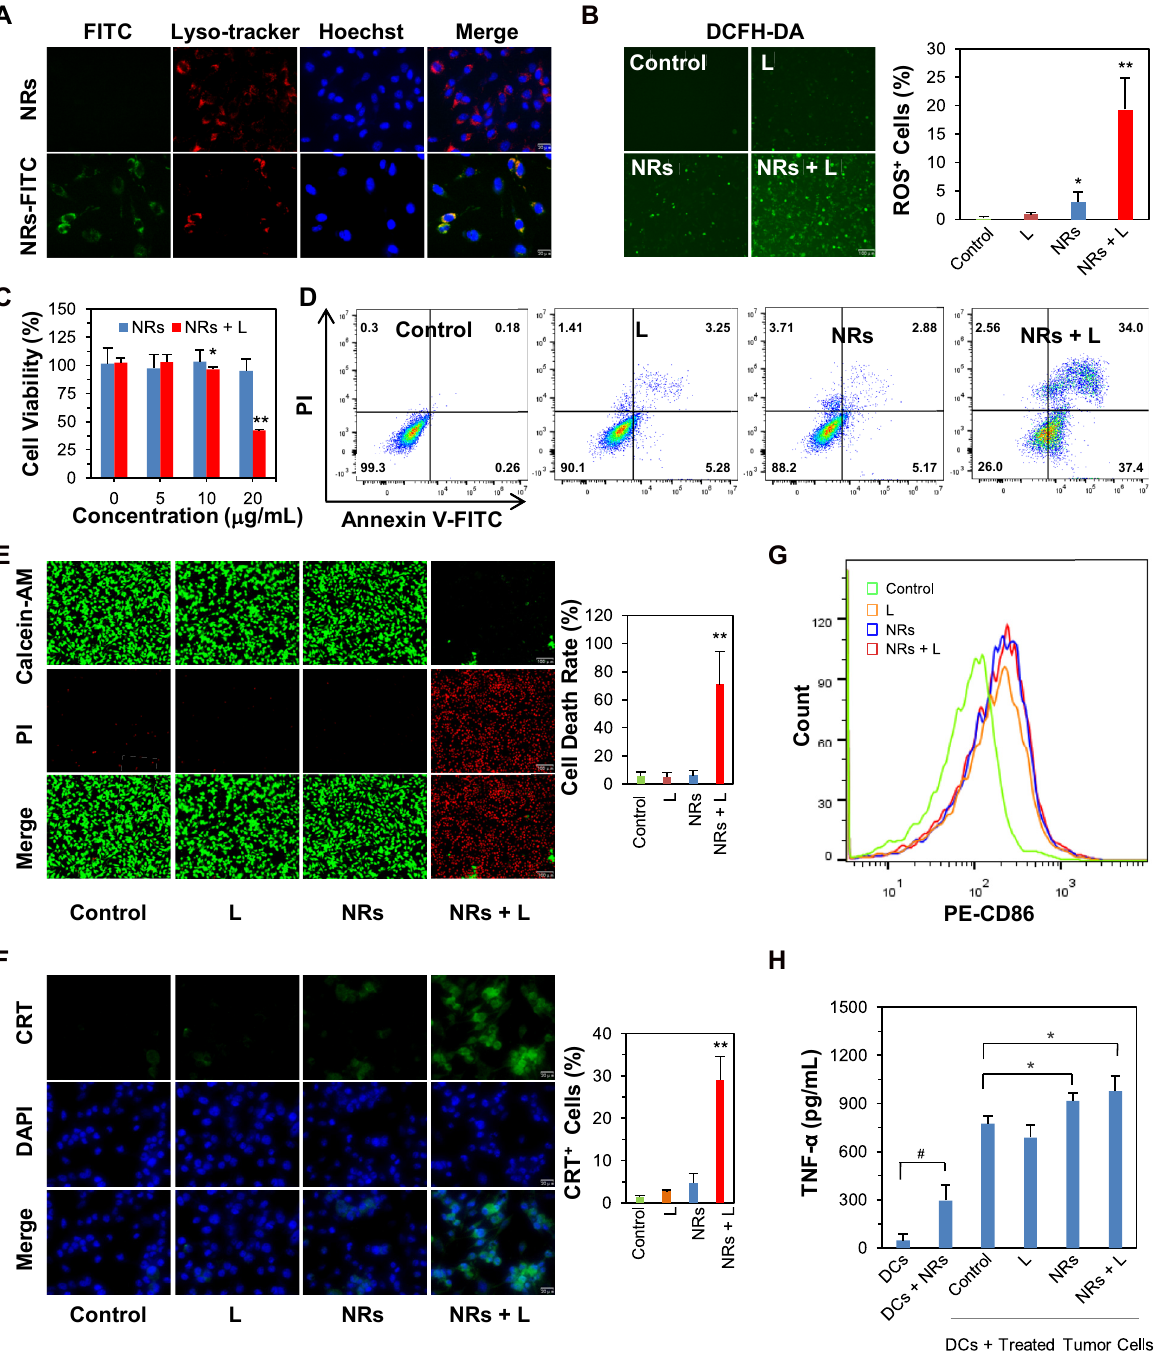
Figure 2: Immunogenic tumor cell death induced by Fe 2 P-PEG-Mal NRs based PTT. (A)FluorescenceimagesofintracellularlocalizationofNRsinPanc02-H7cells.Scalebar:20 μ m.(B)FluorescenceimagesofROSproductionin Panc02-H7 cells stained with DCFH DA (a ROS probe, green). Scale bar: 100 μ m. Bar graph demonstrated percentage of ROS cells ( n = 3, * P < 0.05, ** P < 0.01). (C) Cell viability with or without laser irradiation (980 nm, 0 5 W/cm 2 , 2 min) at different concentrations of NRs ( n = 4, * P < 0.05, ** P < 0.01). (D) Flow cytometric analysis of cell apoptosis induced by different treatments staining with Annexin V-FITC/PI. (E) Fluorescence images of cell death induced by different treatments staining with calcein-AM/PI Live cells green, calcein-AM Dead cells red, PI. Scale bar: 100 μ m Bar graph demonstrated percentage of cell death rate ( n = 3, * P < 0.05, ** P < 0.01). (F) Fluorescence images of CRT on the surface of Panc02-H7 tumor cells. Scale bar 20 μ m. Bar graph demonstrated percentage of CRT cells ( n = 3, * P < 0.05, ** P < 0.01). (G) Flow cytometricanalysisofCD86expressiononthesurfaceofDCsstimulatedbytreatedPanc02-H7cells(gatedonCD11c + cells),(H)ELISAanalysis of TNF α released from DCs stimulated by NRs or treated Panc02-H7 cells ( n = 3, * P < 0.05, ** P < 0.01 and # P < 0.05 vs. indicated